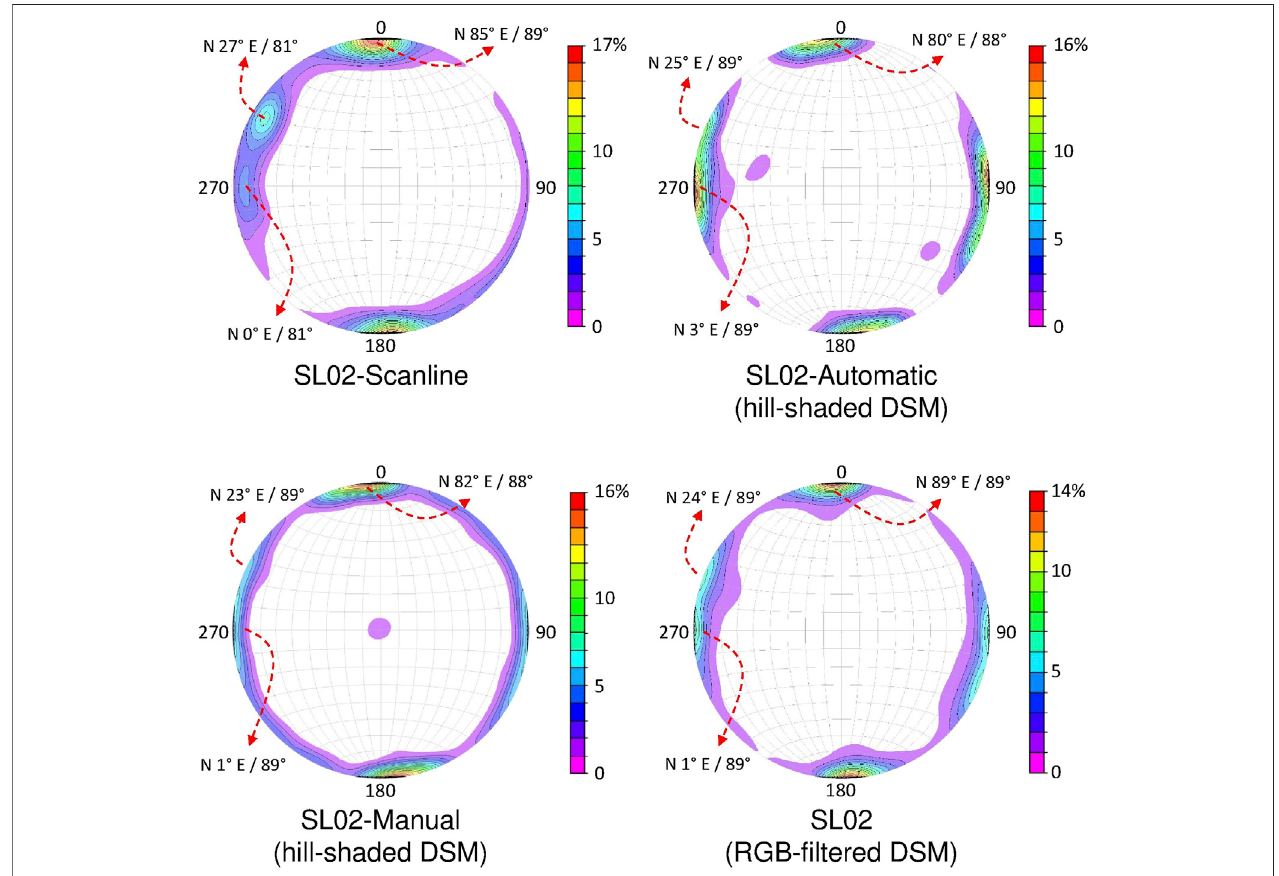
FIGURE 9 | Stereographic projections of fracture planes for SL02, generated from the simple triangulation method. Similar to the result from SL01, the outcome from all DSMs methods is nearly identical to the result from the scanline method.